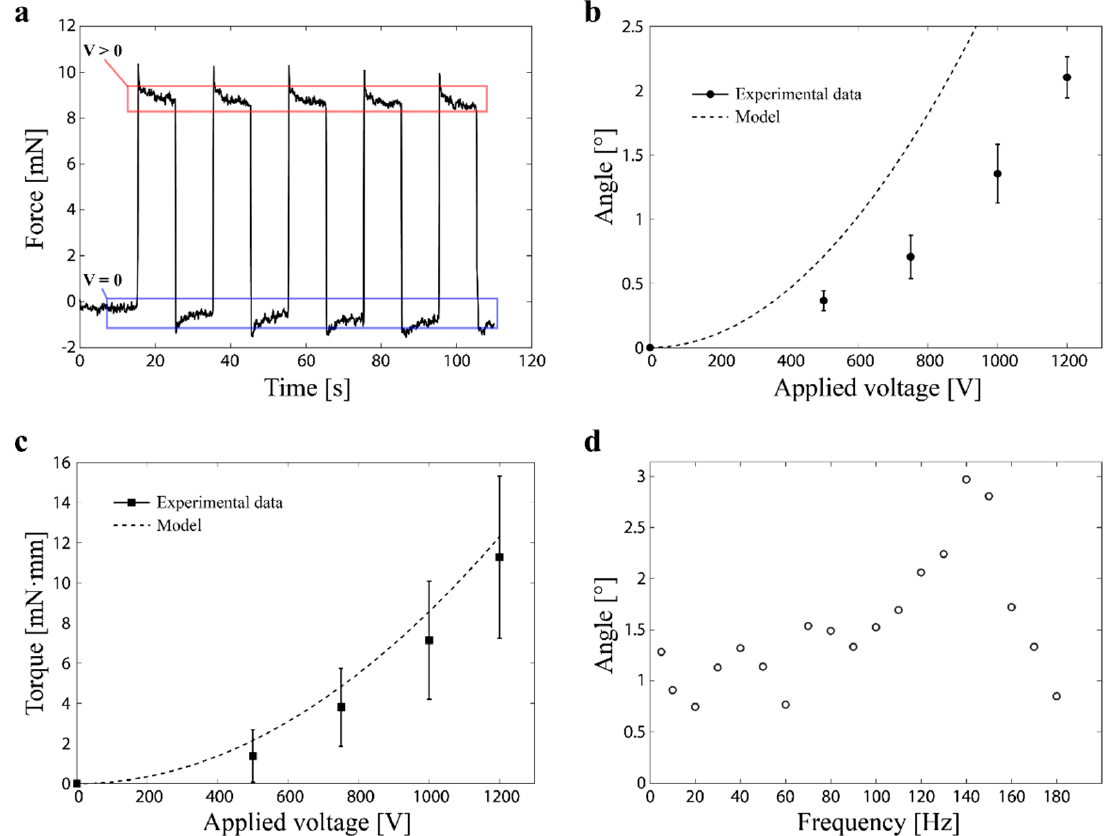
Figure 6. ( a ) Force output the actuator measured by a load cell. ( b ) Measured tip angle as a function of the applied voltage. ( c ) Measured torques as a function of the applied voltage. ( d ) Measured frequency response of the actuator (voltage 1000 V).